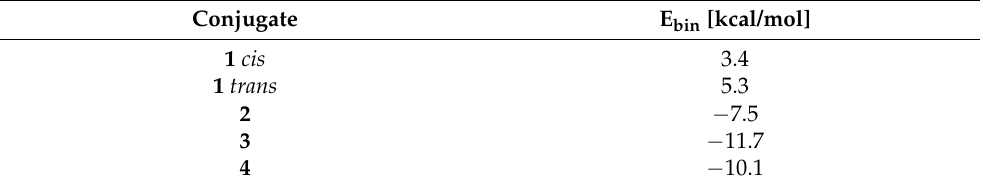
Table 2. Binding energies of CblCN-Pd(II)